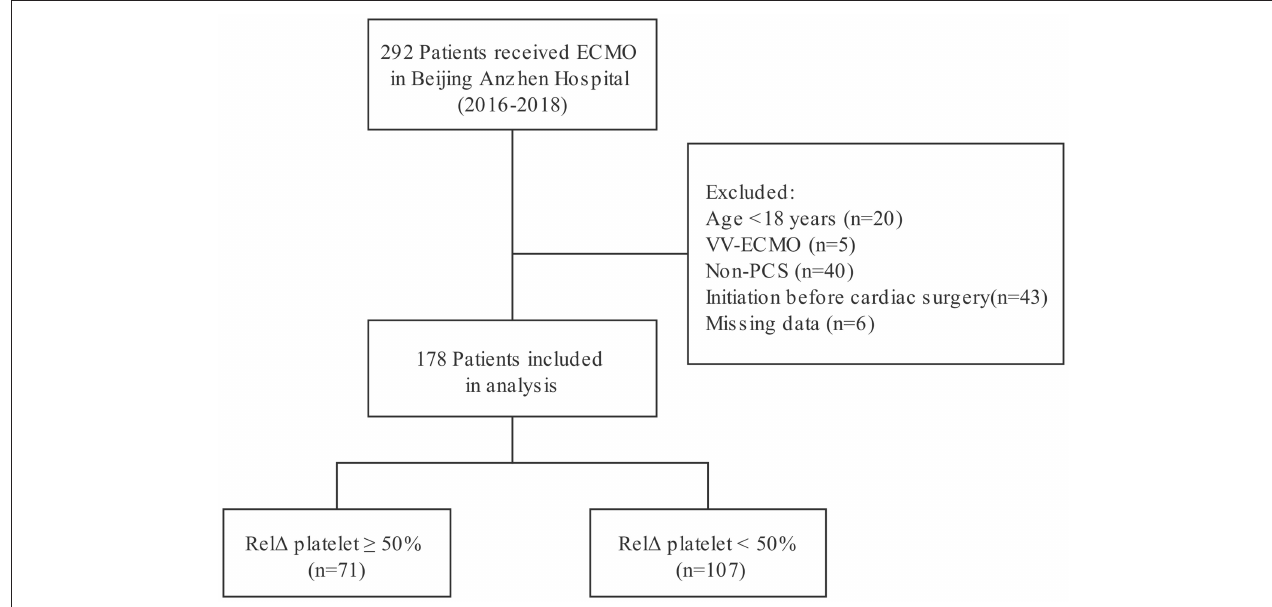
FIGURE 1 | Flow diagram for selection of